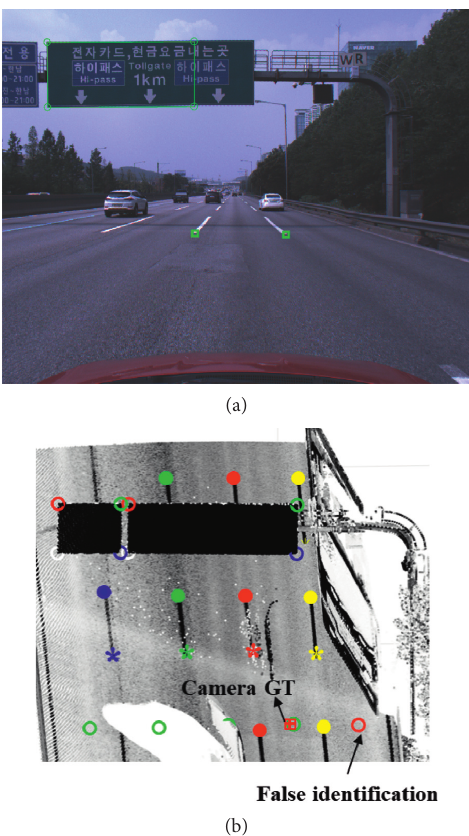
Figure 16: Ego-lane identification failure by a falsely detected road sign: (a) falsely detected road sign; (b) localization